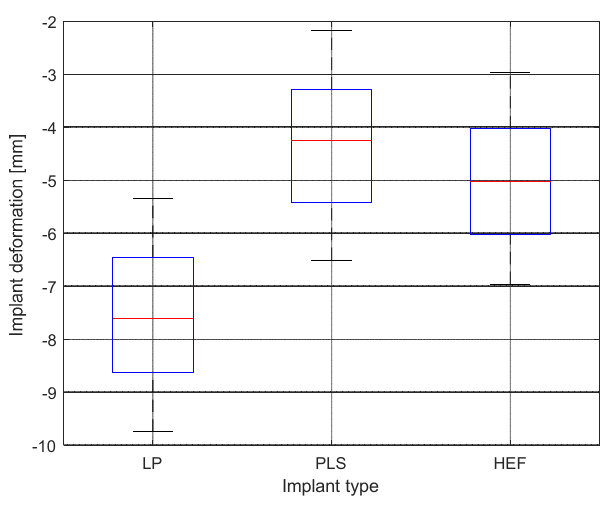
Figure 16. Box plot of ID data.